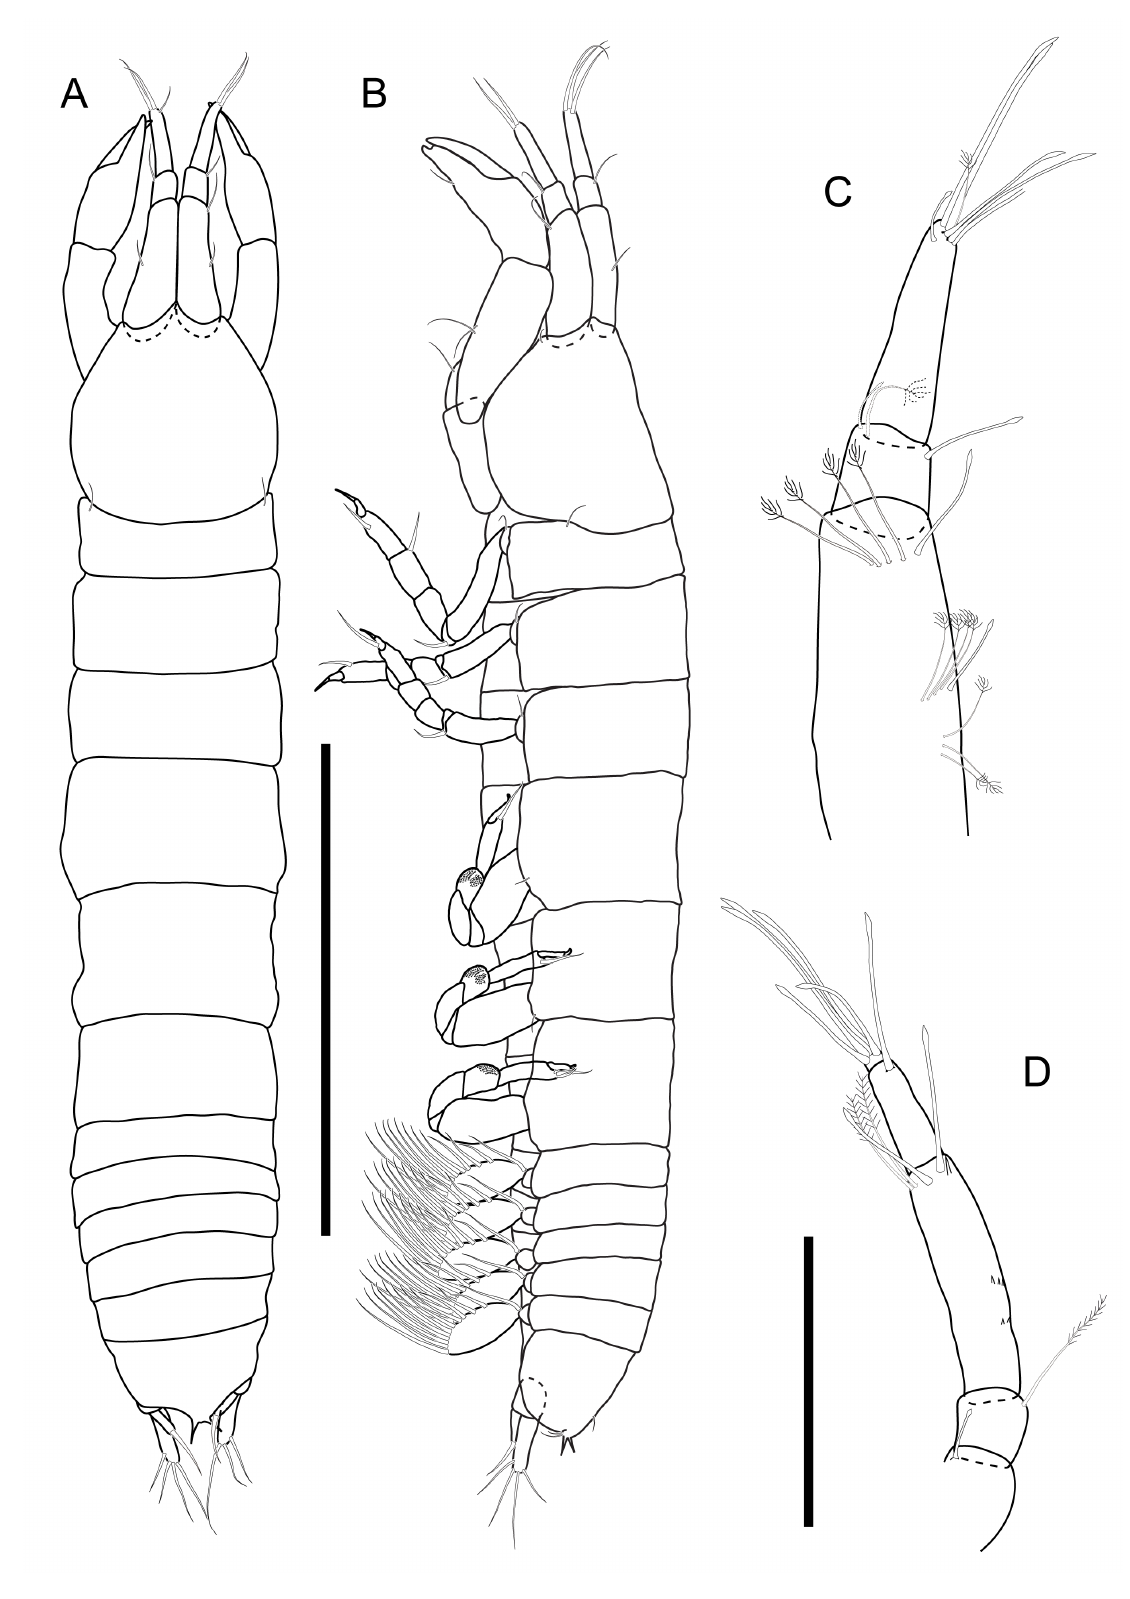
Fig. 14. Typhlotanais priscilae sp. nov., ♀, dissected (MZUSP 38009). A . Dorsal view. B . Lateral view. C . Antennule. D . Antenna. Scale bars: A–B = 1 mm; C–D = 0.1